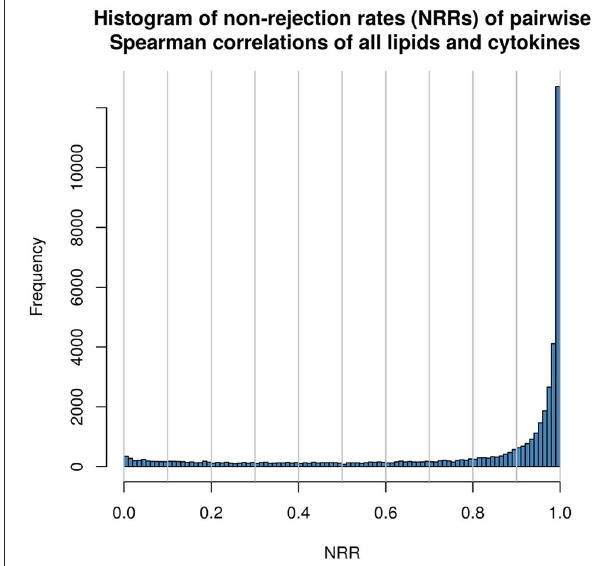
FIGURE 1 | Histogram displaying frequency of non-rejection rates (NRRs) as calculated pairwise between all lipids and inflammatory mediator in the study.